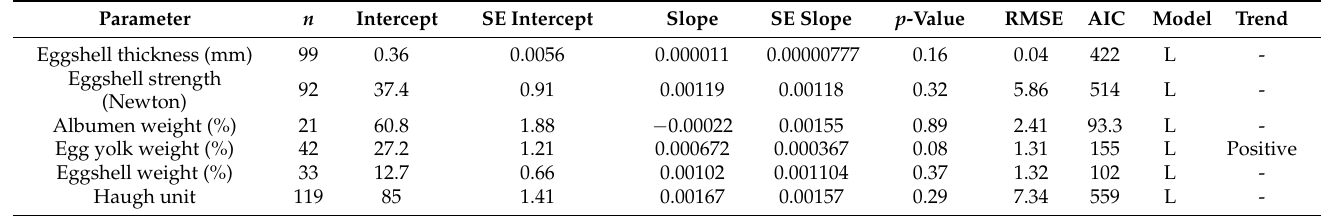
Table 3. Regression equations for the impact of phytogenic extract levels on the egg quality of laying hens.